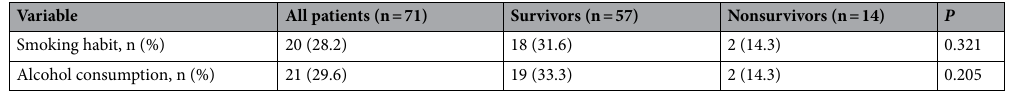
Table 2. Baseline characteristics of elderly patients with organophosphate poisoning, stratified according to status at discharge as survivors or nonsurvivors (n = 71). Categorical variables were presented as numbers with percentages in brackets, while continuous variables were presented as the means and standard deviations. Time of admission was presented as means and standard deviations as well as median and range. * P < 0.05.